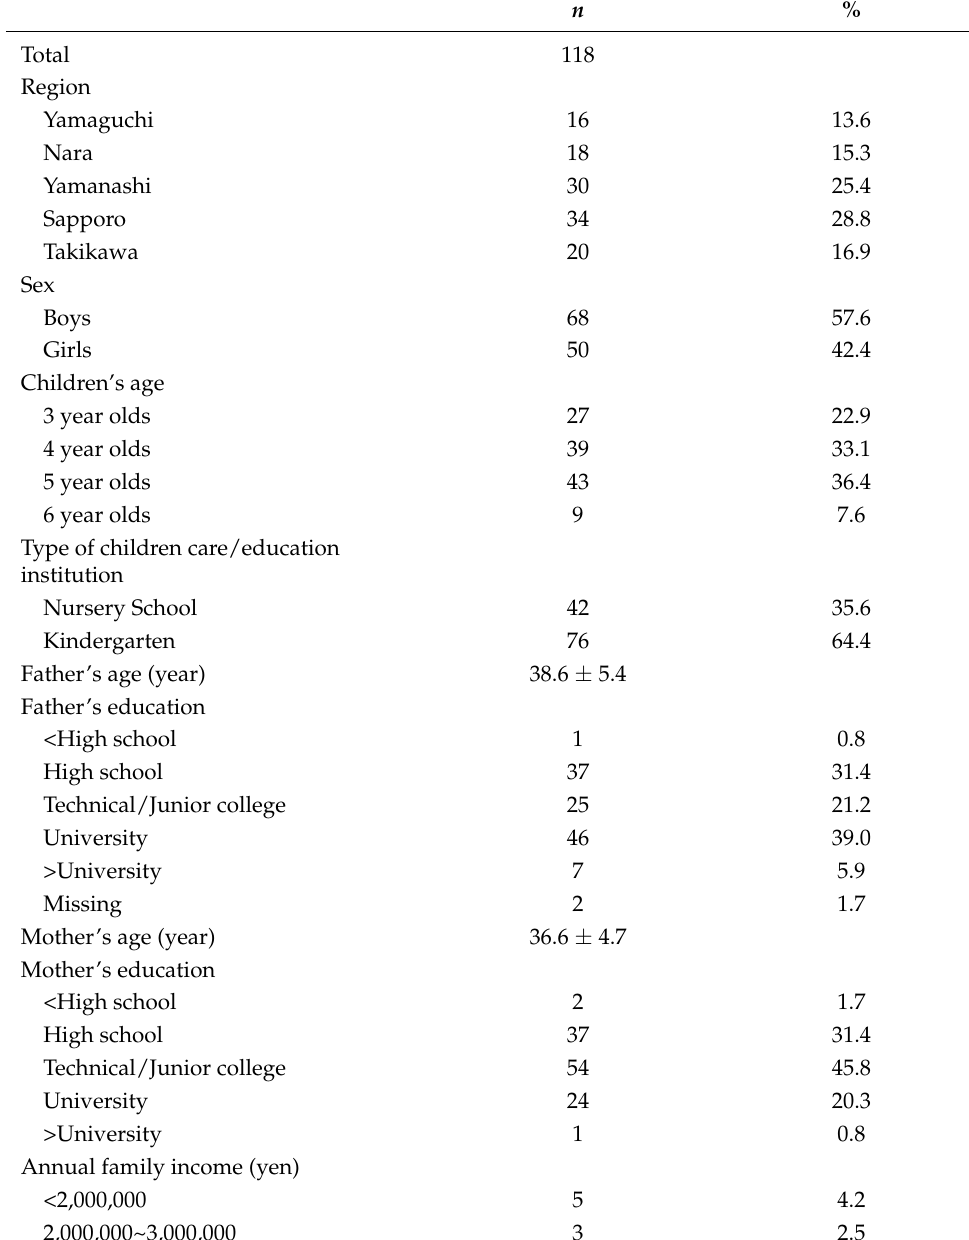
Table 1. General characteristics of children and their